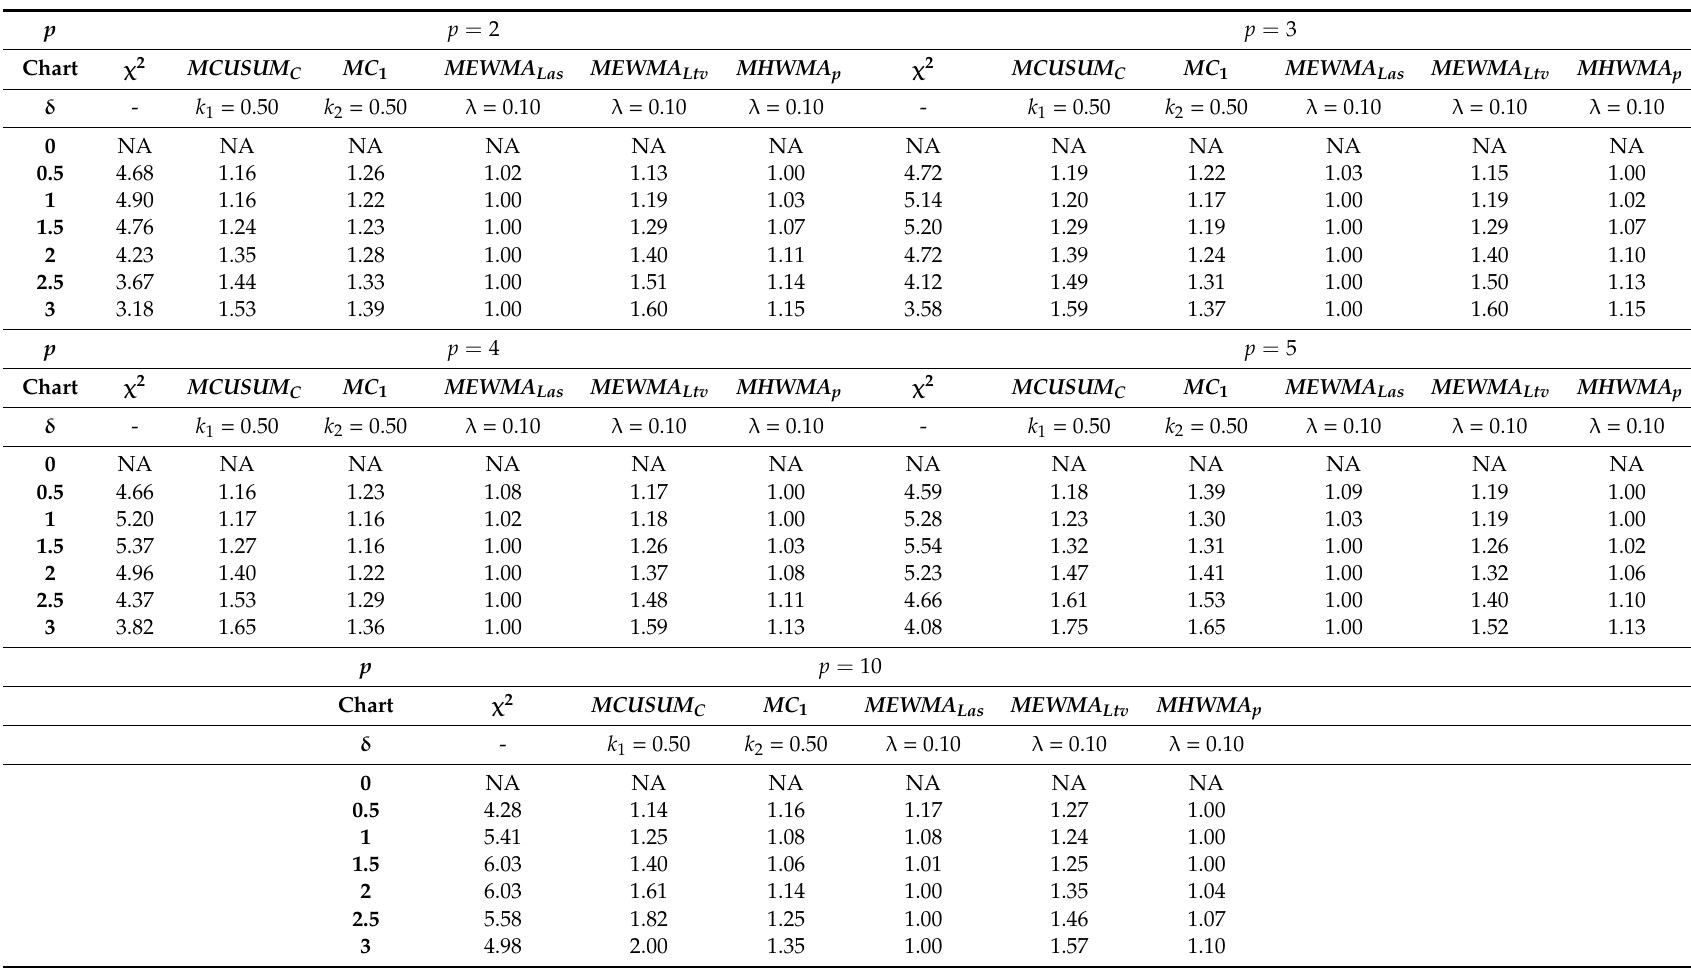
Table 3. Cumulative performance comparison index (PCI) values for di ff erent